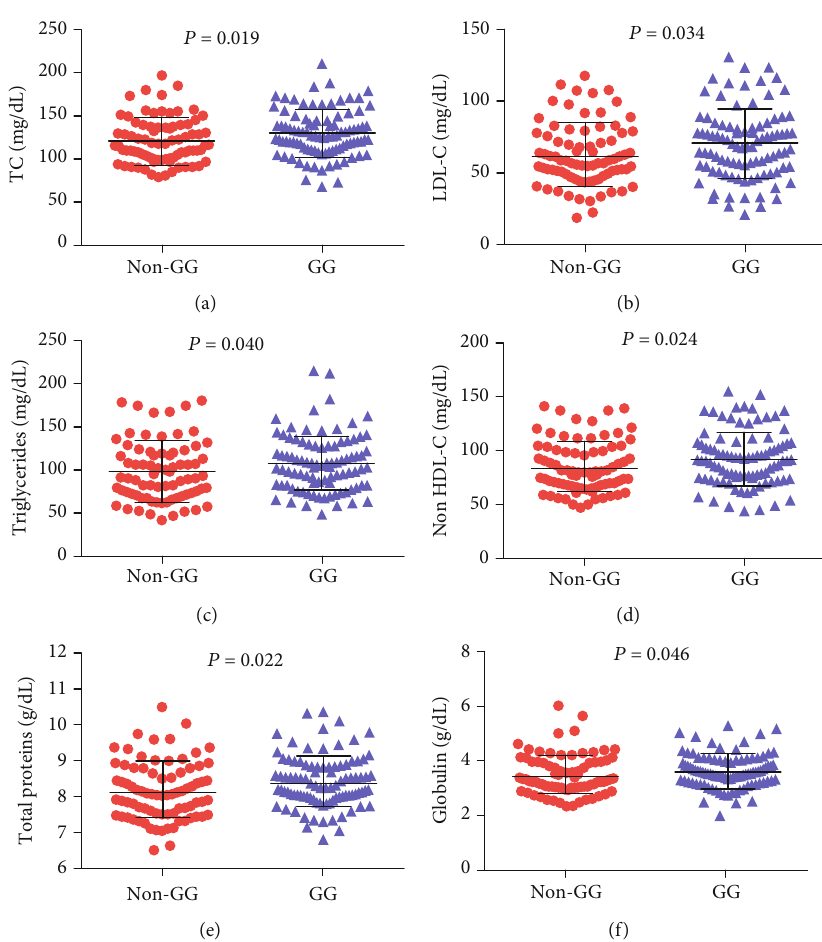
Figure 3: Associations between the GG haplotype and laboratory parameters in individuals with SCD. Carriers of the GG haplotype presented increased (a) total cholesterol (TC) levels, (b) low-density lipoproteins cholesterol (LDL-C) levels, (c) triglycerides, and (d) nonlow-density lipoprotein cholesterol (non-HDL-C) (all P values obtained by the Mann-Whitney U test). Carriers of the GG haplotype also had presented increased (e) total protein levels ( P value obtained with t -testing) and (f) increased globulin levels ( P value obtained by the Mann-Whitney U